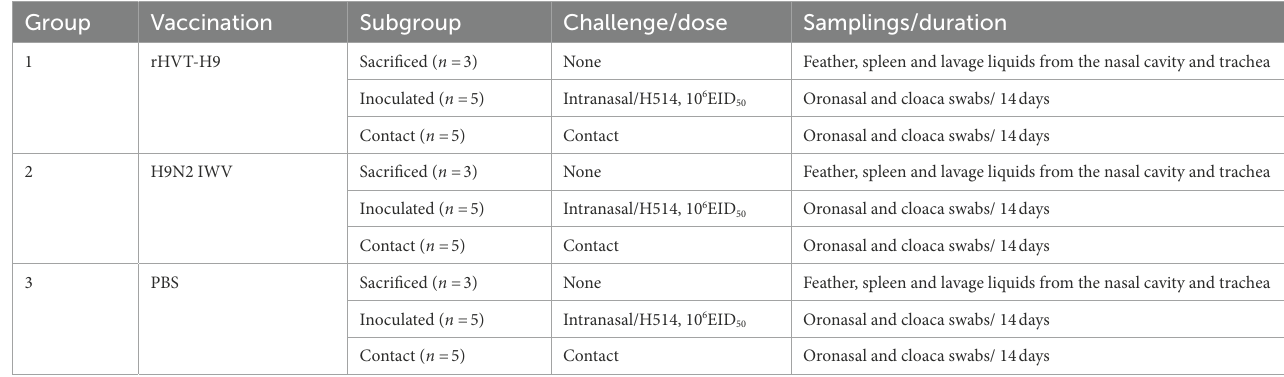
TABLE 2 Experiment design to quantify the efficacy of the rHVT-H9 in the transmission of H9N2 AIV in chickens with PTAs.